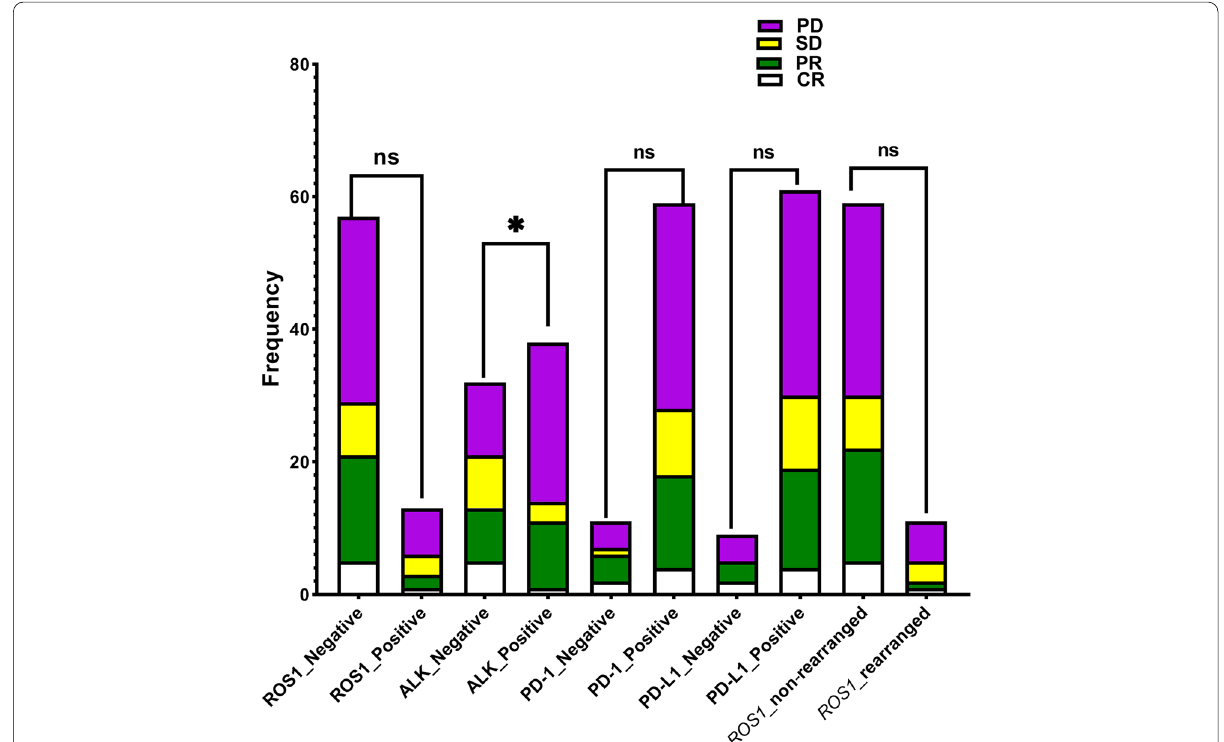
Fig. 4 Bar plot showing the response rate in relation to ROS1, ALK, PD‑1, and PD‑L1 protein expression as well as to ROS1 gene rearrangement. *Significant at p <